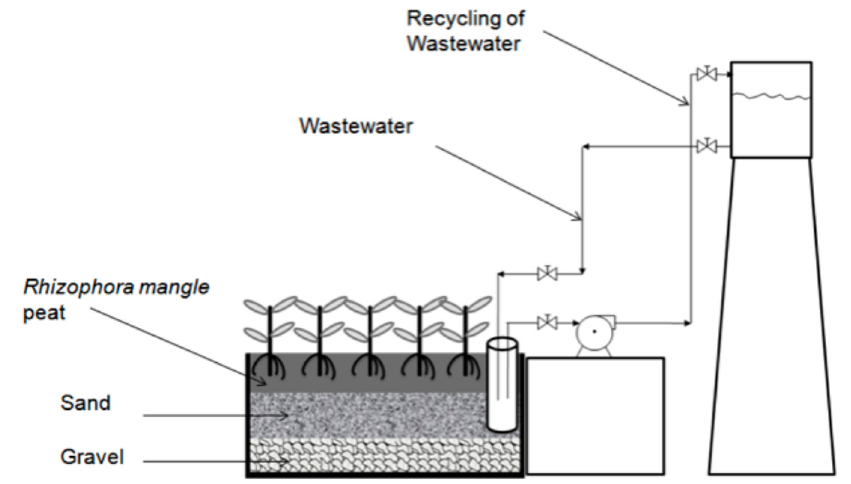
Figure 1. Diagram of the treatment system on secondary urban residual waste waters with subsurface recirculation.